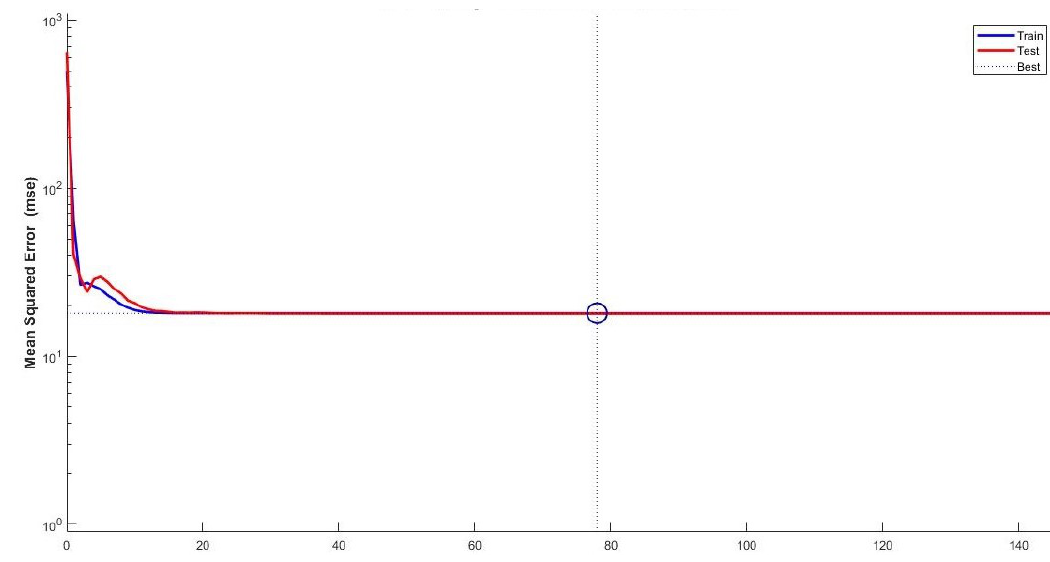
Figure 2. Error analysis neural network.